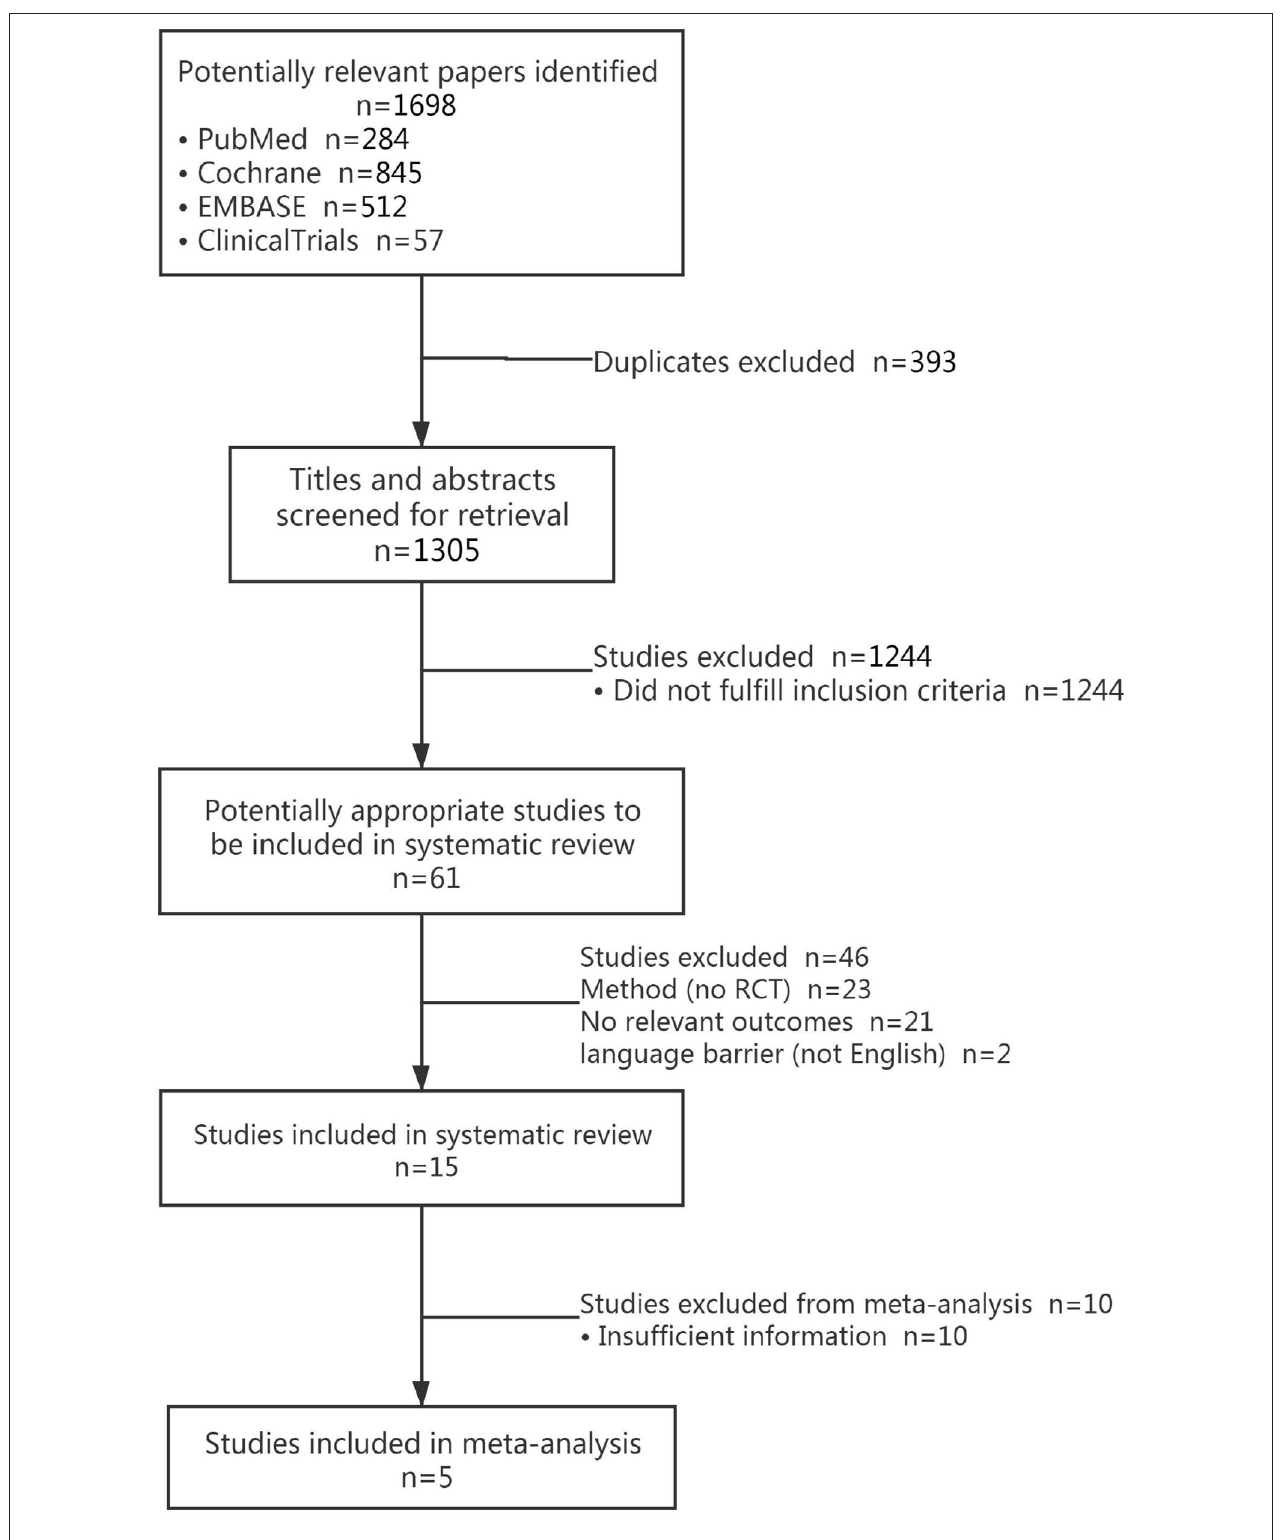
FIGURE 1 | Flowchart of study selection